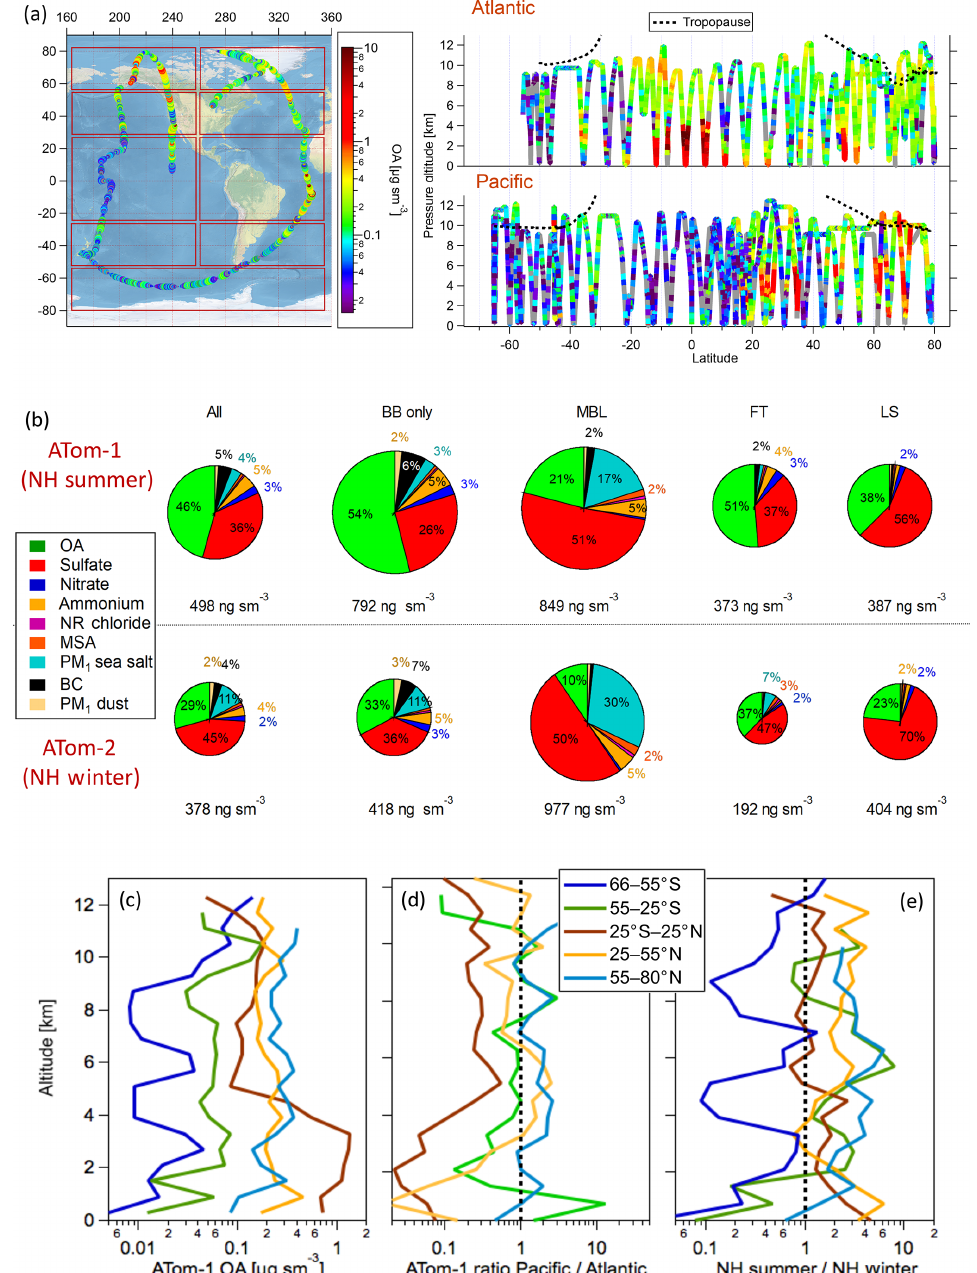
Figure 2. (a) ATom-1 DC-8 flights during the August 2016 deployment. Red boxes indicate regions used for the latitude averaging of the model results. (a) Vertical distribution of OA concentrations (µgsm − 3 ) along ATom-1 flight tracks. (b) Average submicron aerosol composition as measured in the biomass-burning-influenced regions (BB only) and the non-BB-influenced regions including the marine boundary layer (MBL), free troposphere (FT), and lower stratosphere (LS) for ATom-1 and ATom-2. The BB-influenced air masses were filtered using the PALMS data (see Sect. 3.1). Contributions below 2% are shown but not labeled on the pie chart. In ATom-1, “BB only” represents 24% of the data, clean MBL 8%, clean FT 57%, and clean UT 12%, whereas in ATom-2 “BB only” represents 3%, clean MBL 8%, clean FT 74%, and clean UT 16%. (c) The average OA vertical profiles are shown for each latitude region as are (d) the ratios between the Pacific and Atlantic Ocean in each region. (e) The seasonal contrast in OA concentrations is calculated as the ratio of OA concentrations between the NH summer (ATom-1) and NH winter (ATom-2) campaigns. The corresponding plots for ATom-2 can be found in Fig.